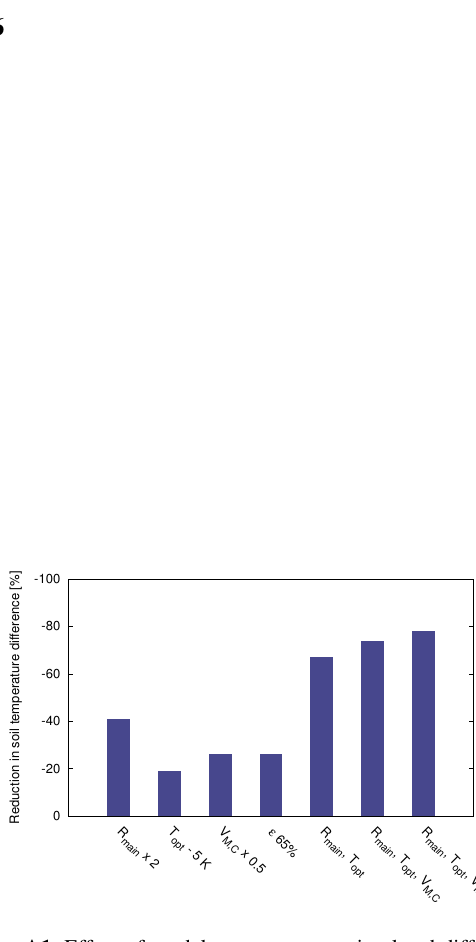
Figure A1. Effect of model parameters on simulated difference in topsoil temperature between the Dynamic and Without simulations. The individual effects of four varied parameters are shown, which significantly reduce the temperature difference. These are the spe- cific maintenance respiration rate R main , the optimum temperature of photosynthesis, T opt , the molar carboxylation rate of Rubisco, V M,C and the porosity (cid:15) of the bryophyte and lichen layer (see Ta- ble A1 for details). Also shown are the combined effects of R main and T opt , R main , T opt and V M,C , as well as R main , T opt , V M,C and (cid:15) . The effect on the temperature difference is shown in percentage of